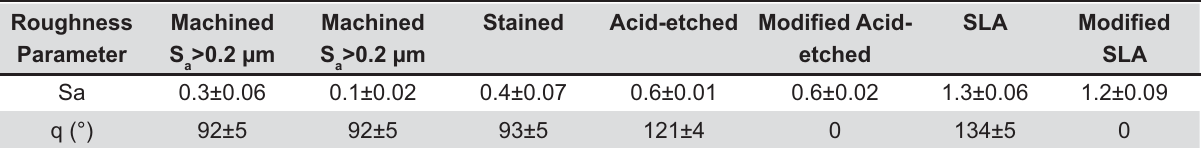
Table 1- Arithmetic mean deviation of the surface (S Sandblasted/acid-etched